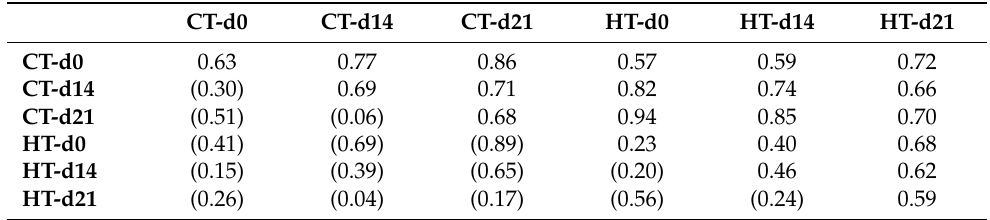
Table 2. Separation of gut microbial communities between treatments and sampling events. Average Bray-Curtis dissimilarity between (upper triangle) and within (diagonal) groups and ANOSIM R values (lower triangle, in